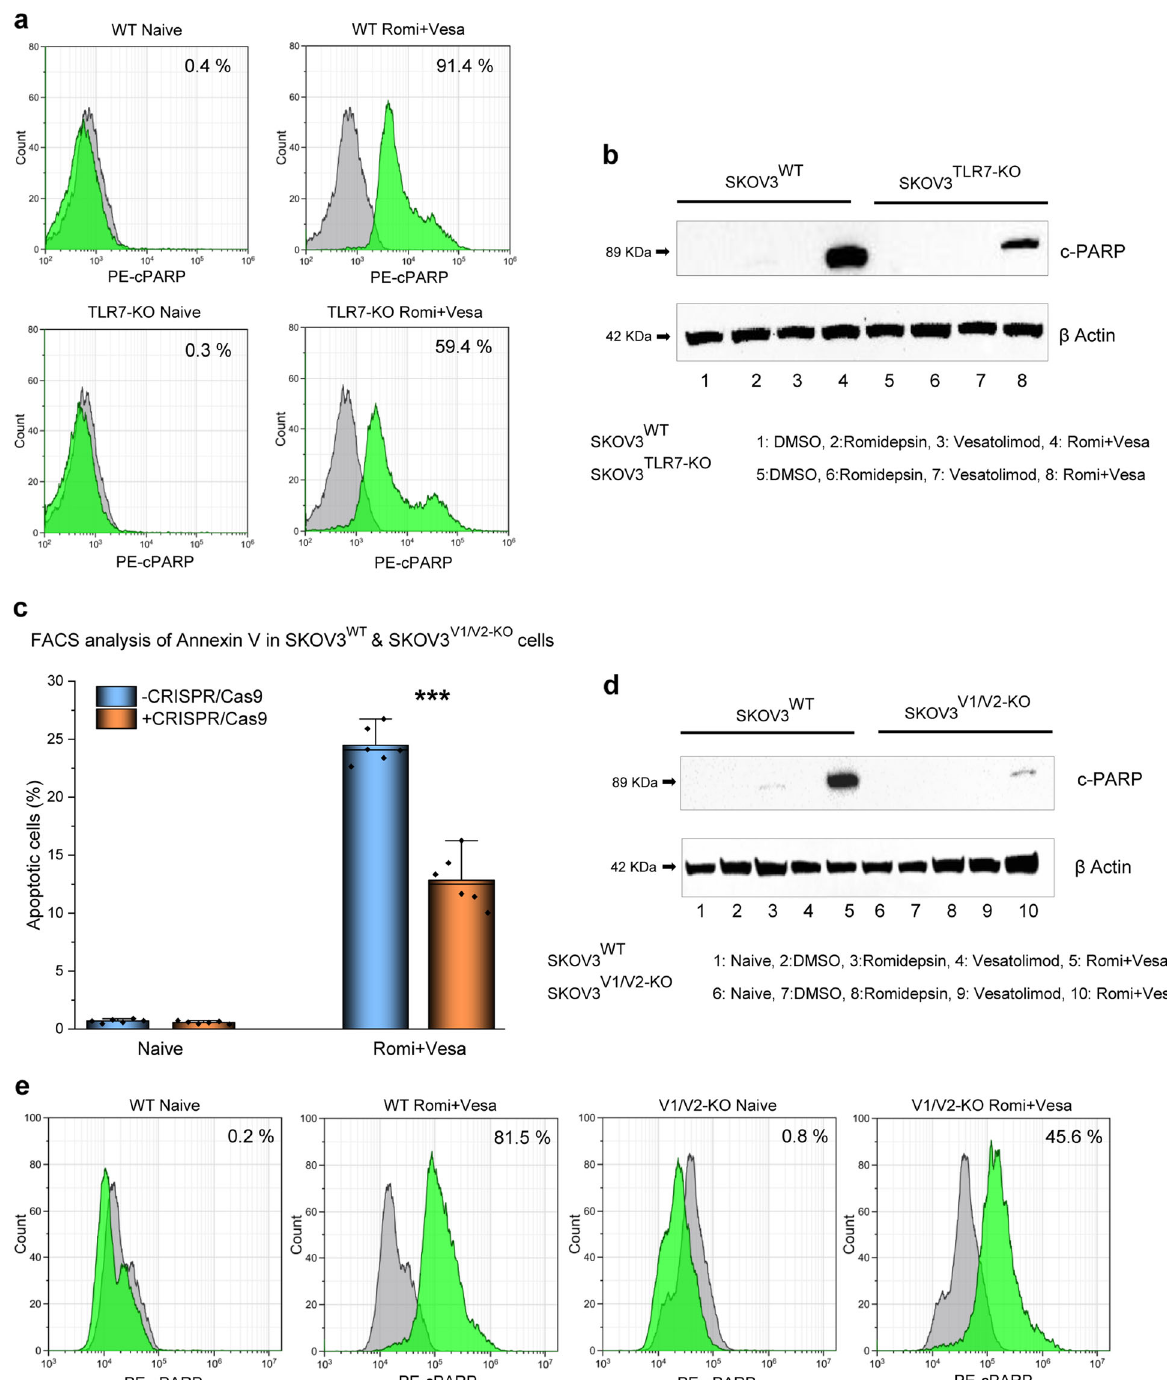
Fig. 4 TLR7 and HERV-V1/V2 are direct mediators of HTCT-induced apoptosis. a CRISPR/Cas9 ablation of TLR7 impairs HTCT-induced apoptosis in SKOV3 cells, indicating that apoptosis is mediated by TLR7 in this system (determined by PARP cleavage FACS). Isotype: grey and sample: green. b Western blot analysis for c-PARP, demonstrating the same effect. c HERV-V1/V2 ablation reveals the role of the HERV-V1/V2 gene product as substrate for TLR7 (cytometric FACS measurement of annexin V); * p < 0.05, ** p < 0.01, *** p < 0.001 (paired Student ’ s t test; two-tailed). d HERV-V1/V2-ablated SKOV3 cells are less susceptible to HTCT-induced apoptosis than the non-ablated parental cells (western blot). e About 36% reduction in apoptosis is observed in SKOV3 HERV-V1/V2KO cells (FACS analysis of PARP cleavage). Isotype: grey and sample: green. Results are representative of n ≥ 3 using c-PARP as a sentinel for cell death. Although SARM1 protein tended to be reduced after HTCT, the difference in protein synthesis of undigested NF κ B1 (p105 form) was reduced, apoptosis between ablated and normal cells was not signi fi cant suggesting that I- κ B α was hypophosphorylated, the NF κ B/I- κ B α (Supplementary Fig. 16), indicating that SARM1 is not likely to complex did not dissociate, and NF κ B1 was not transcribed; play a role as a TLR7 adaptor in this cell line. this effect was con fi rmed a posteriori with immunotechniques